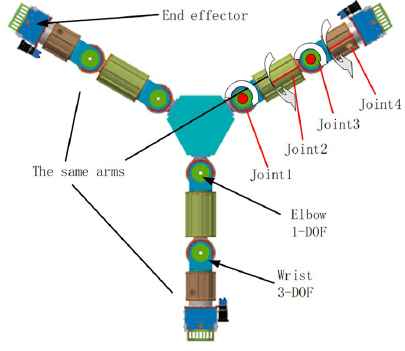
Figure 3. DOF (degree of freedom) configuration of the Beijing Astronaut Robot.